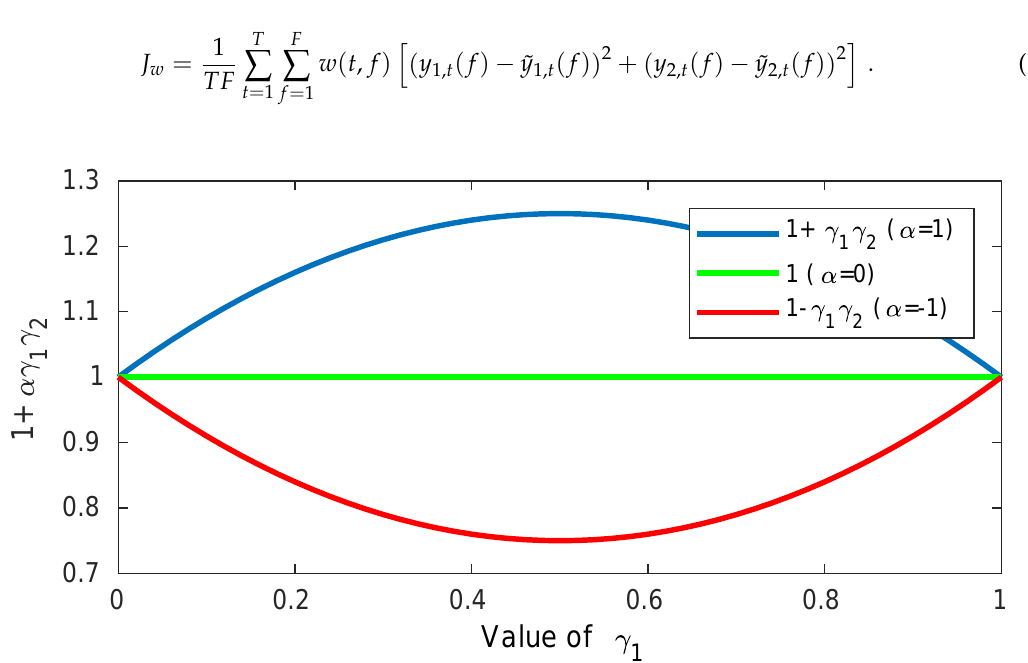
Figure 5. Loss weight w ( t , f ) with respect to γ 1 when α = 1 ( solid line ) and α = − 1 ( dashed ). In the case of α = 1, time-frequency bins which two sources are mixed equally has large weights. In the case of α = − 1, ones which one source is dominant has large